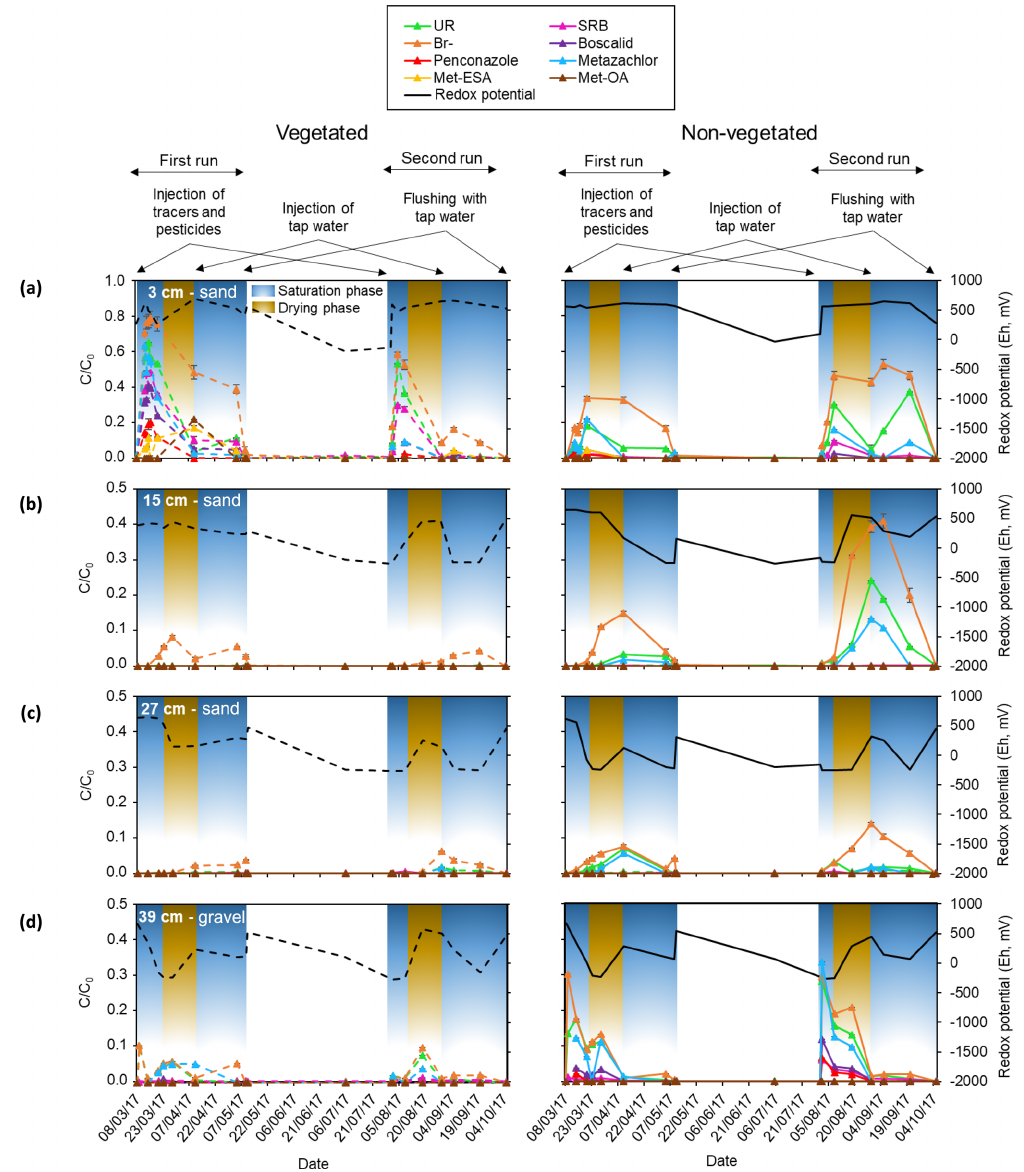
Figure 4. Breakthrough curves of the different tracers, pesticides and their TPs in terms of relative concentrations ( C/C 0 ; obtained by scaling with the input concentrations) measured in the pore water during the first and second run for the different zones, phases (saturation and drying) and the following depths: (a) 3cm, (b) 15cm, (c) 27cm and (d) 39cm. Changes in redox potential are displayed on the right y axis (Eh in mV). The different injections performed during each run are displayed on top of the figure. Note that the scale of the relative concentrations corresponding to the sampling depth of 3cm is